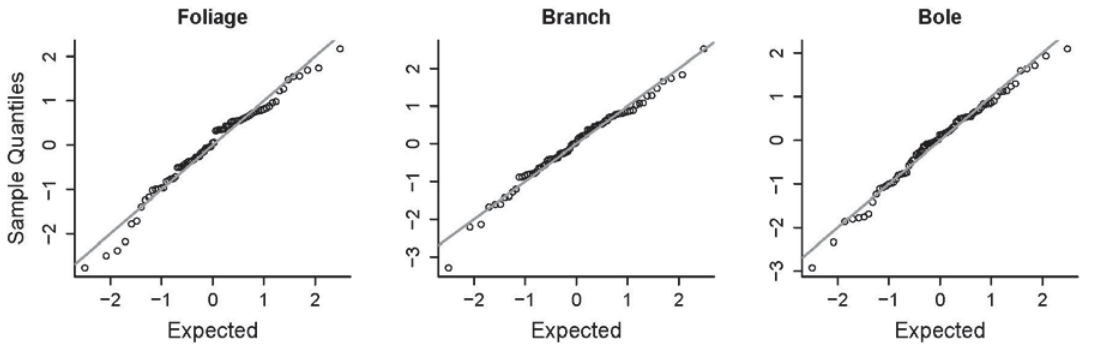
Figure 2. Normal probability plots using transformed residuals for the selected system (5) of